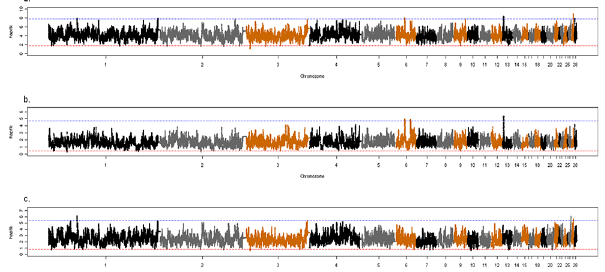
Fig 3. Manhattan plot of hapFLK analysis over the entire genome with 5 clusters. Blue (red) line indicates the upper (lower) 0.05% of hapFLK distribution, for, (A) within all breeds, (B) within white breeds, and, (C) Within brown